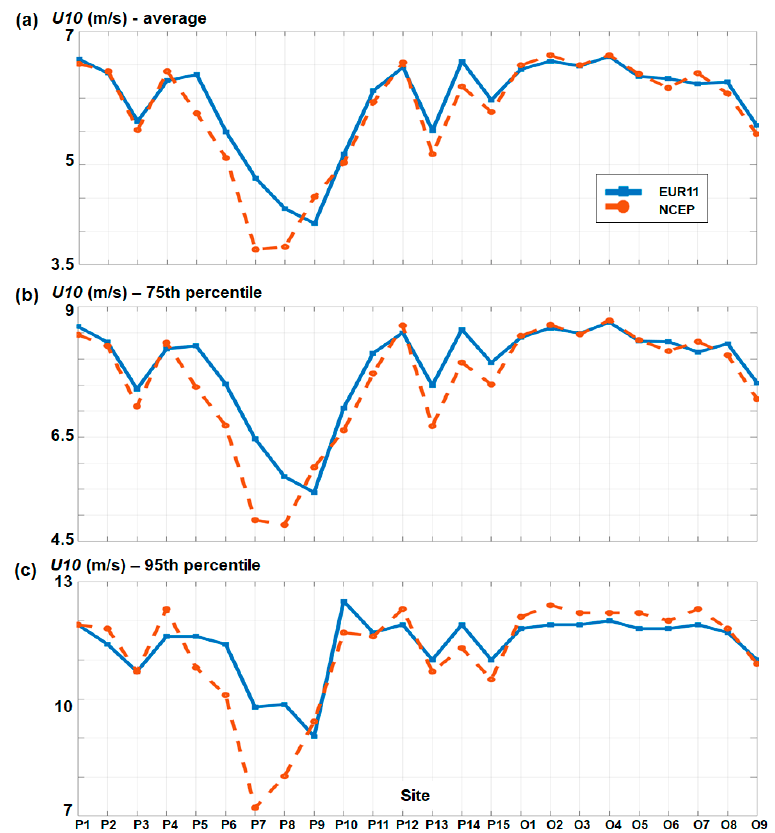
Figure 5. Distribution of the U10 wind conditions in the sites considered, for EUR11 and NCEP datasets, time interval 1987–2009: ( a ) average values; ( b ) 75th percentile values; and, ( c ) 95th percentile values.